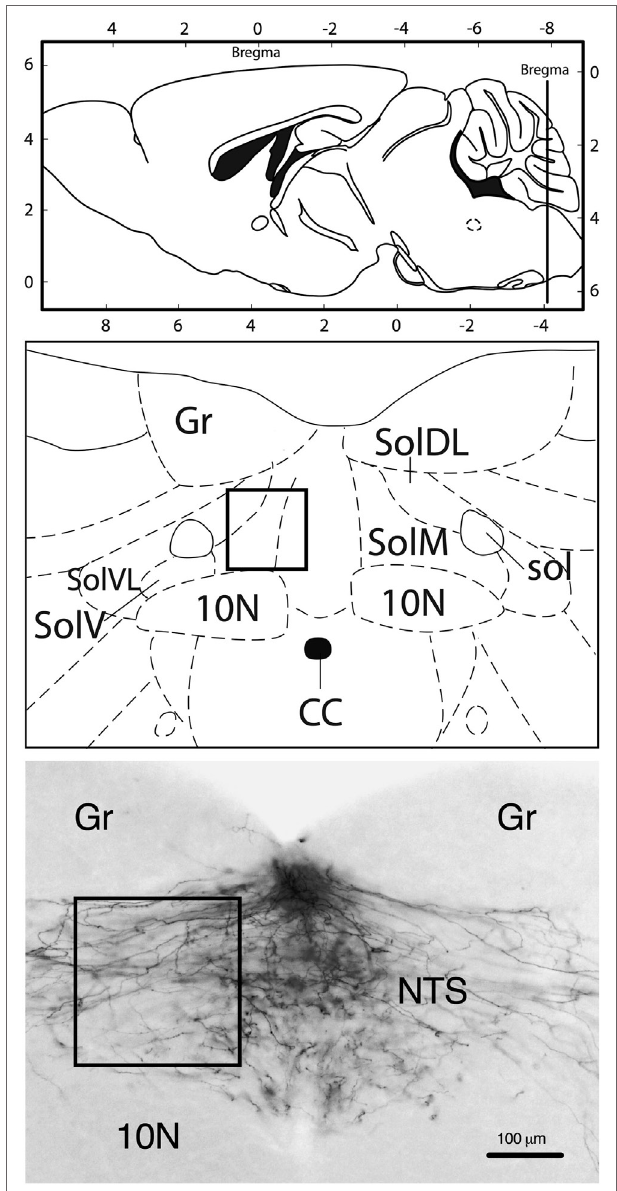
FigUre 1 | Neuroanatomical localization of the region that was used for quantification (rectangle). Approximate rostrocaudal level of the nucleus of the solitary tract (NTS): bregma − 7.8 mm (caudal of the DiI crystal implantation site in the area postrema). Representative image (10-fold magnification) of DiI staining illustrating that labeling was only present in fibers, but not in neuronal cell bodies. 10N, vagus nerve nucleus; CC, central canal; Gr, gracile nucleus; sol, solitary tract; SolDL, solitary nucleus, dorsomedial part; SolM, solitary nucleus, medial part; SolV, solitary nucleus, ventral part; SolVL, solitary nucleus, ventrolateral part. Schematic drawings: modified and reproduced with permission from Ref. (19).